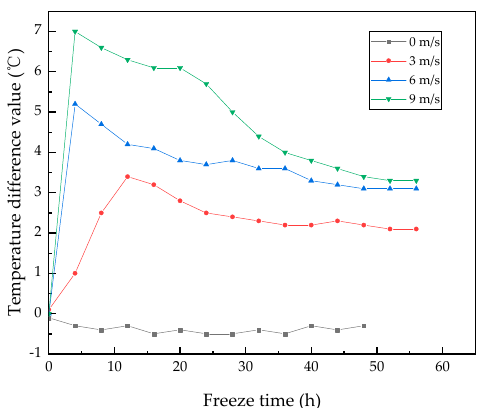
Figure 10. The temperature difference changes between B1 and B13 with the freezing time. It can be seen from Figure 10 that when u = 0 m/d, the differences between B1 and B13 were small and stable at about 0.3 °C. It was considered that these differences were symmetrically distributed. When there was flow, the temperature differences between the two points increased obviously. The larger the velocity, the larger the temperature differ- ence between the two points. At the same velocity, the temperature difference first in- creased rapidly and then decreased slowly and gradually stabilized. When u = 3 m/d, 6